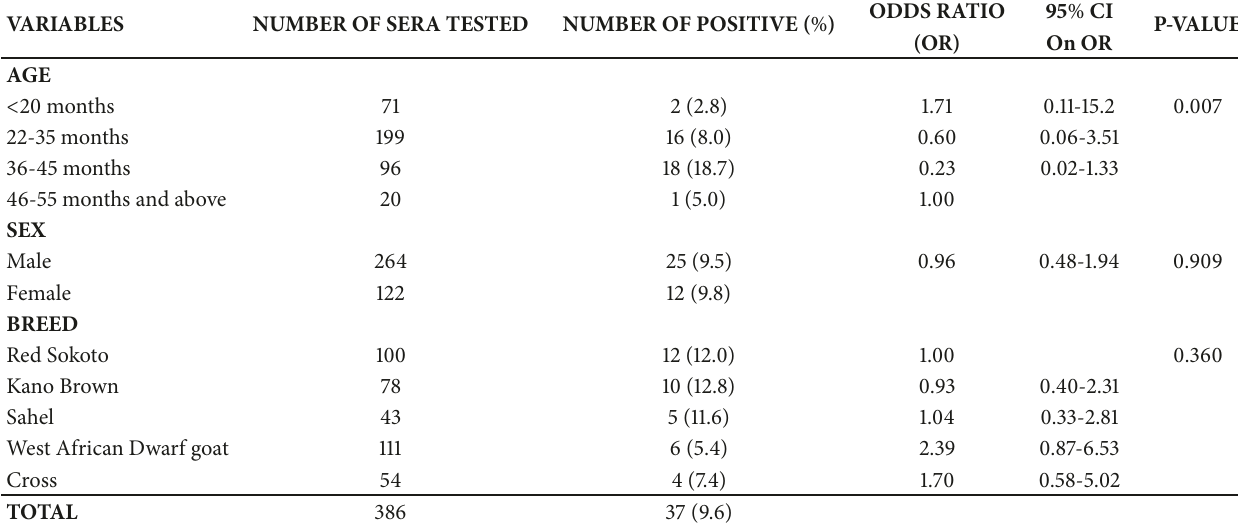
Table 2: Seroprevalence of antibodies to Brucella in goats sample in Wukari based on age, sex, and breeds.